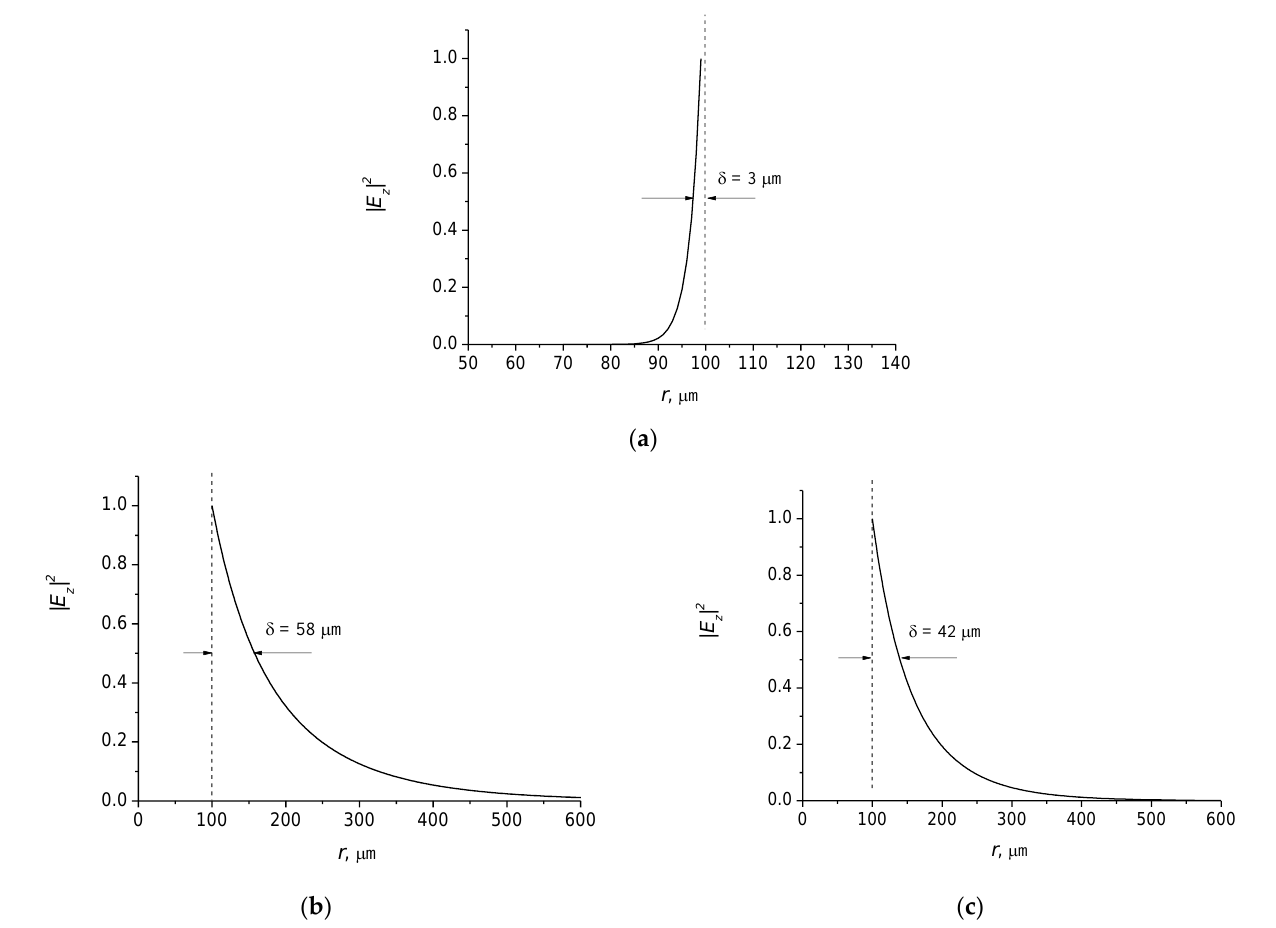
Figure 2. Field intensity distributions at the wire-dielectric boundary. ( a )—inside wire; ( b , c )—outside wire; 𝜀 𝑑 = 1.0 (𝑏); 𝜀 𝑑 = 2.56 (𝑐); 𝑟 0 = 100 μm, σ = 10 7 𝛺 −1 𝑚 −1 , 𝜔 = 0.9 THz , λ = 2.1 mm.